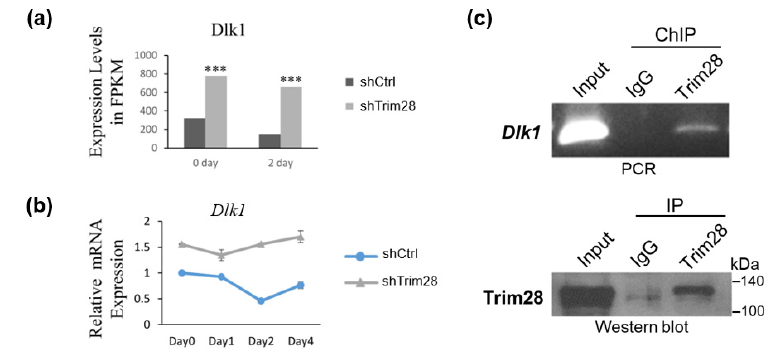
Figure 3. Knockdown of Trim28 increases Dlk1 mRNA expression in 3T3-L1 cells. ( a ) Dlk1 expression level in RNA-seq at day 0 and day 2 in control and Trim28 KD 3T3-L1cells. *** p < 0.001. ( b ) The kinetic of Dlk1 mRNA expression during FDMI induction for differentiation in control and Trim28 KD 3T3-L1cells. ( c ) Chromatin-IP (ChIP)-qPCR. ChIP was performed in day 0 3T3-L1 cells by anti-Trim28 or control IgG. The precipitated genomic DNA was analyzed by semi-quantitative PCR with Dlk1 primers positioned at − 481 to − 341 bp upstream of the transcriptional start site (TSS). 1% volume of each cell lysate was analyzed by PCR to determine the input signals. The IP process was also monitored by western blot as shown in lower panel.